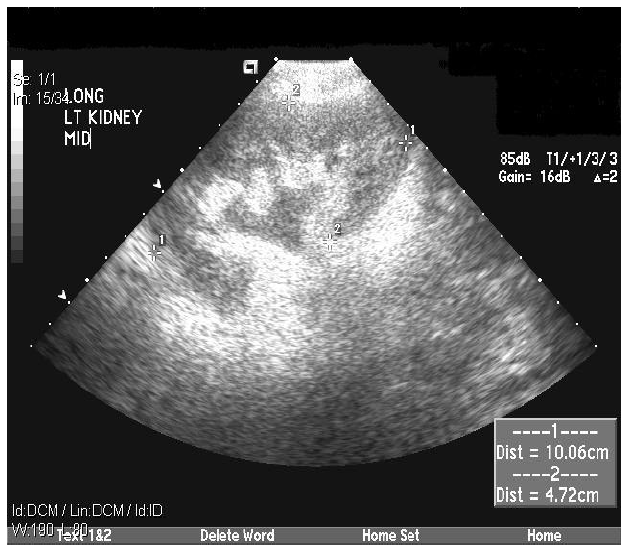
FIGURE 3. USG abdomen shows left kidney with hydronephrosis.